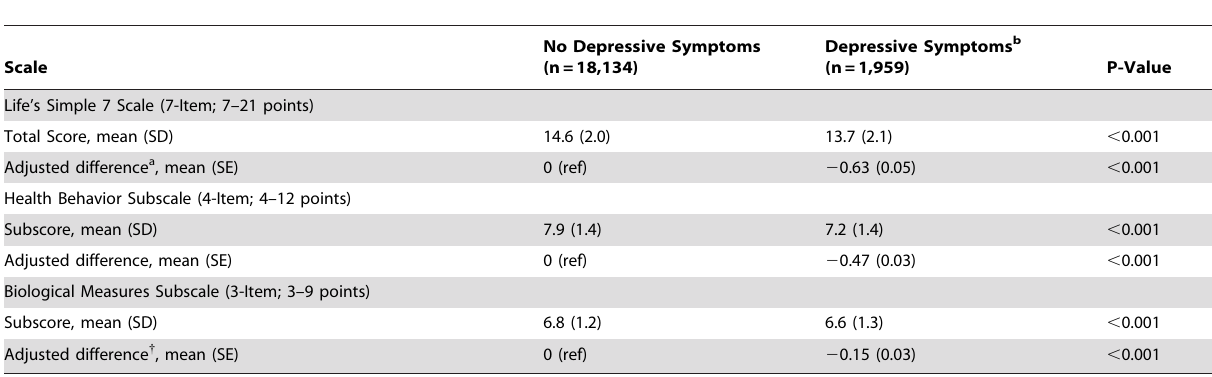
Table 4. Life’s Simple 7 Total Score, and Health Behavior and Biological Factor Subscores and Adjusted Differences in Scores Among Participants With Versus Without Depressive Symptoms.